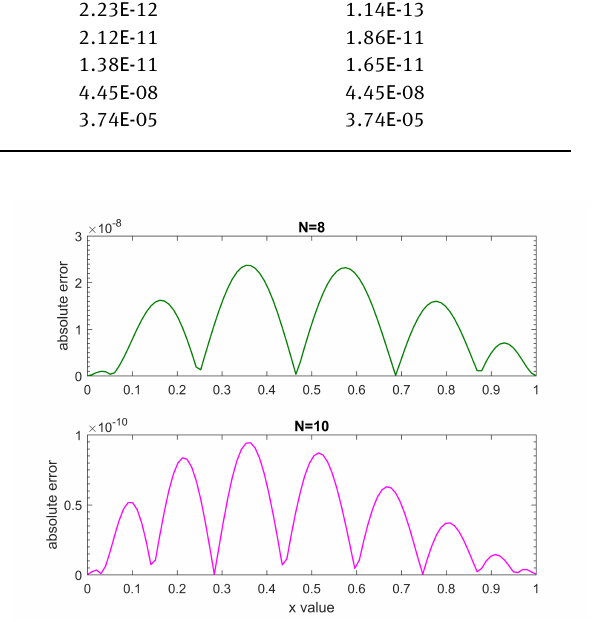
Fig. 5: Absolute errors at N = 8 and N = 10 for example 4.